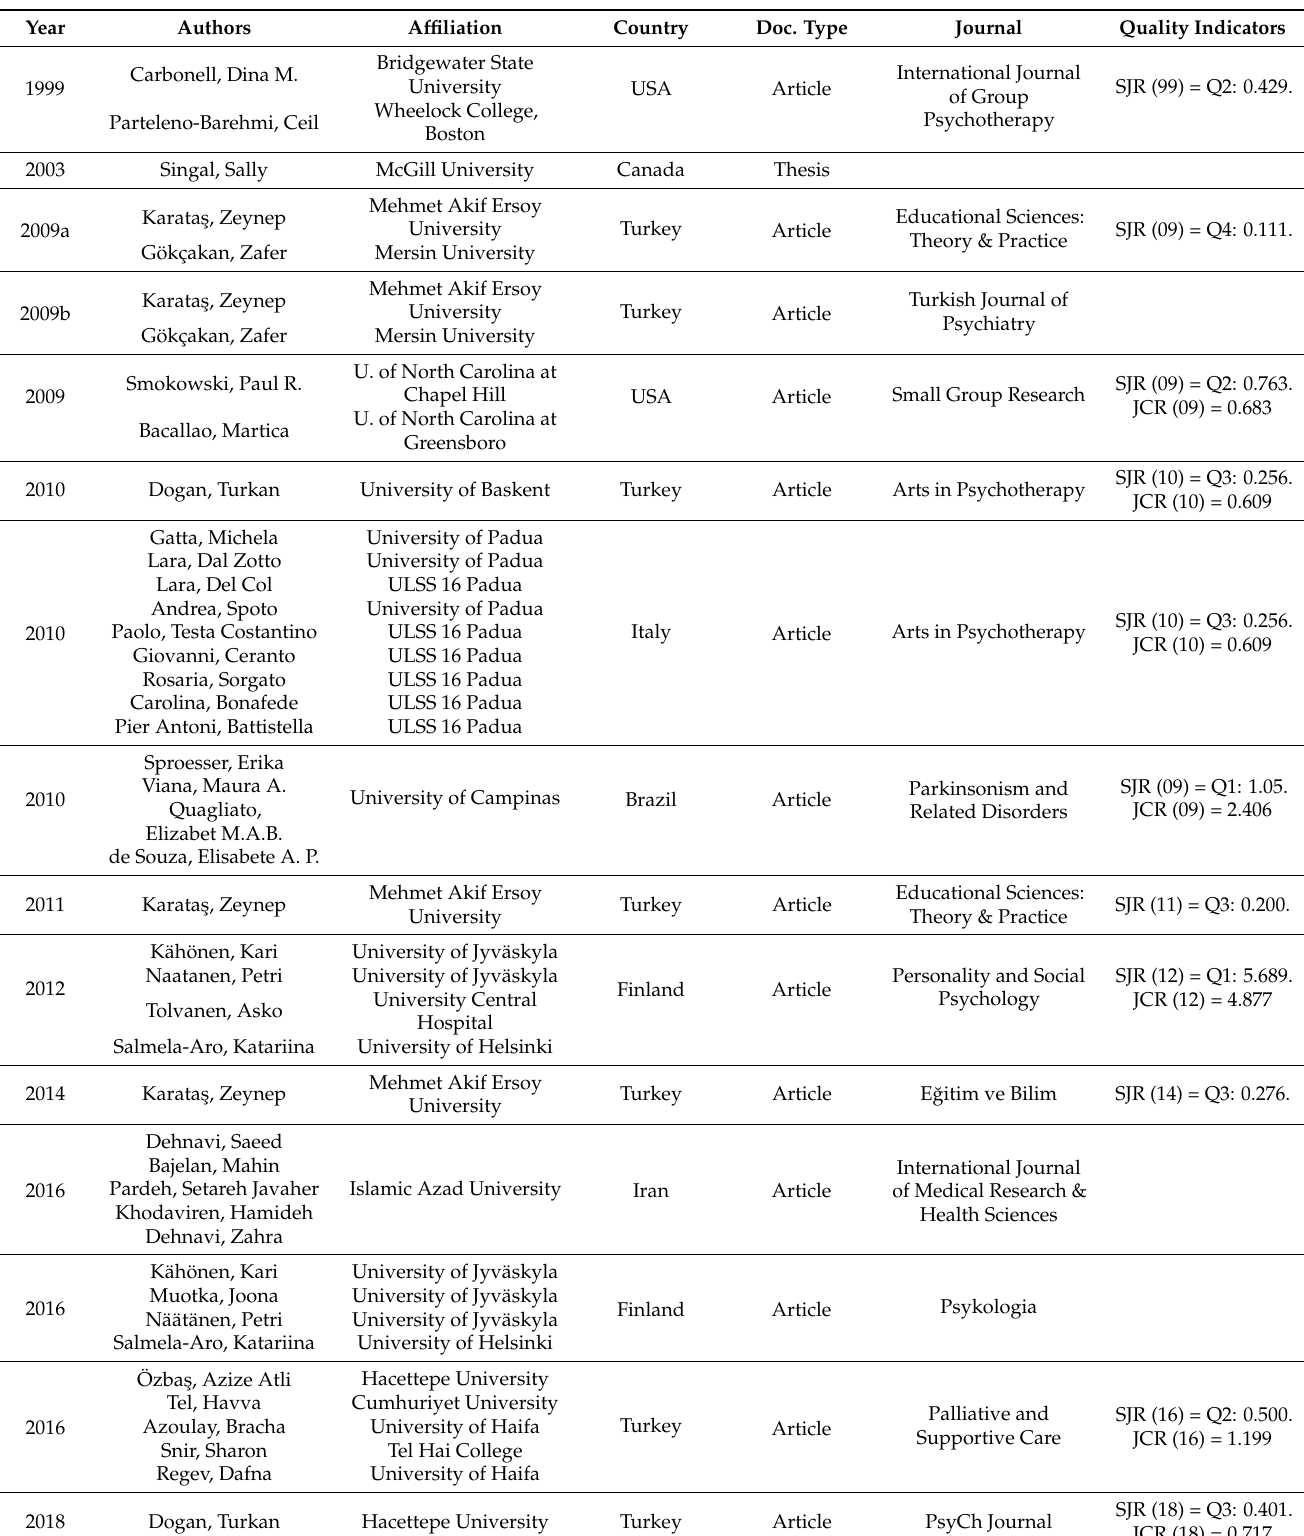
Table 1. Bibliometric data pertaining to the retrieved